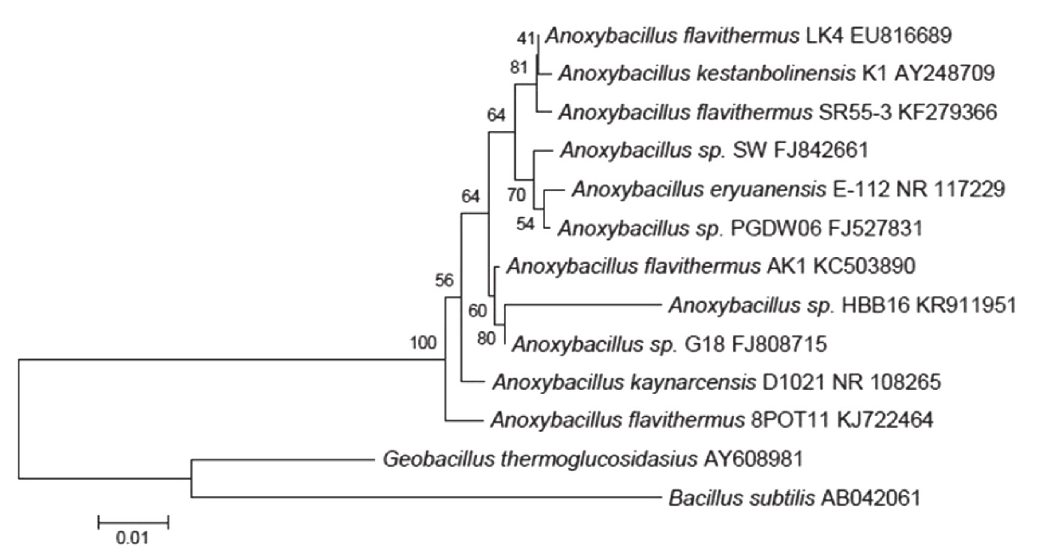
Fig. 1 – Phylogenetic tree resulting from the analysis of the 16S rDNA sequences of Anoxybacillus sp. HBB16. The tree was constructed using the neighbor-joining method. The scale bar indicates a distance of 0.01 substitutions per site.